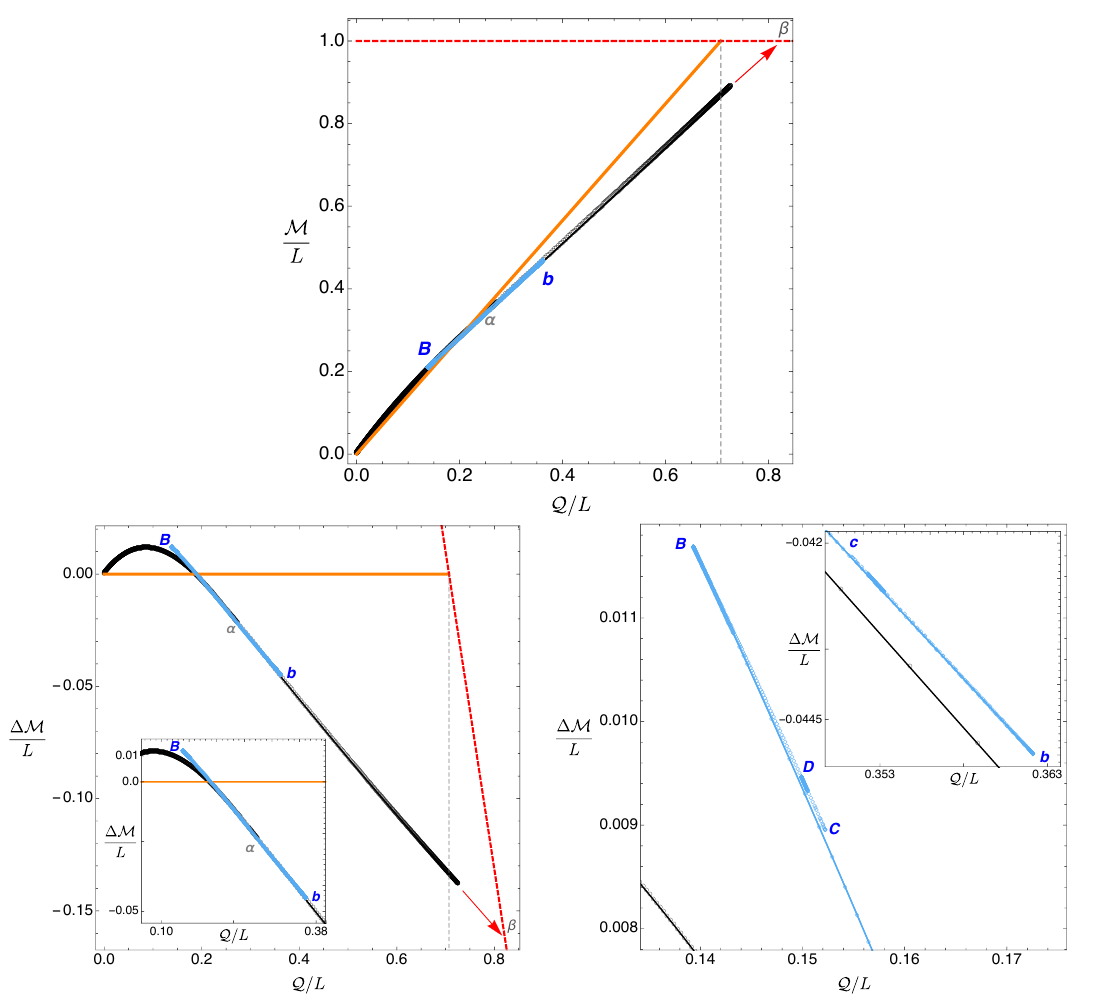
Figure 9 . Soliton families with e = 1 . 855 ( e c < e < e ). Top panel: the quasilocal charge-mass S diagram is now much different from the e < e c case as better seen in the bottom plots. Bottom-left panel: for e > e c the main soliton curve (black disks) no longer has a Chandrasekhar limit; instead it extends from the origin all the way down to point β on the red dashed line. On the other hand, the secondary soliton family (blue diamonds curve) is now confined in a window ( Bb ) of quasilocal charge and with mass above the main soliton. Bottom-right panel: zoom of the left plot to amplify the cusp structures BCD · · · and bc · · · that appear on both sides of the secondary soliton family.